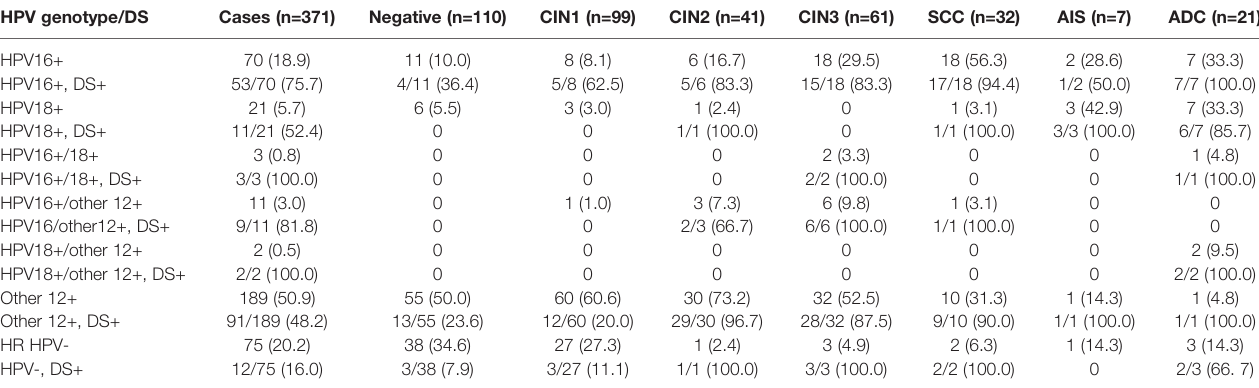
TABLE 4 | Relationship of HPV genotypes and severity of cervical lesions and the positive rate of